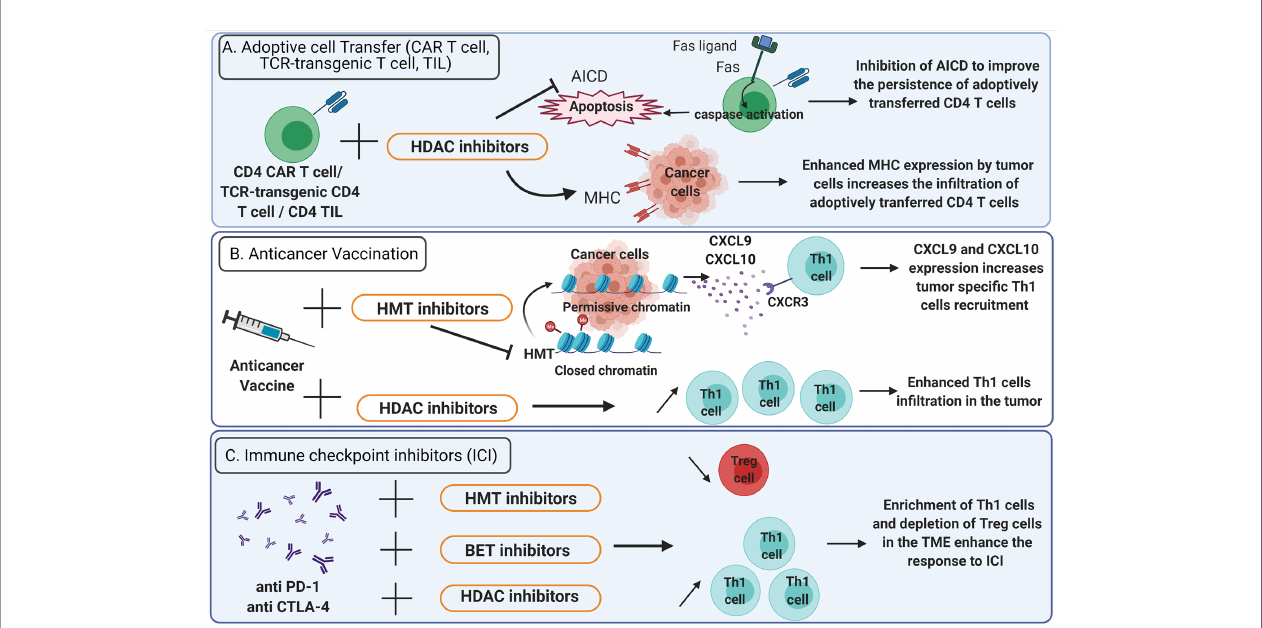
FIGURE 3 | Epigenetic therapies potentiate the ef fi cacy of anticancer immunotherapy. (A) Adoptive cell transfer. To improve the persistence of adoptively transferred CD4 + CAR T cells, TCR-transgenic CD4 + T cells or CD4 + TIL in the TME, activation induced cell death (AICD) can be inhibited using HDAC inhibitors (bar-headed line). AICD is mediated by Fas-Fas ligand interactions and triggers the activation of caspases that lead to apoptosis (solid arrows). HDAC inhibitors also enhance MHC expression on tumor cells thus increasing the in fi ltration of adoptively transferred CD4 + T cells. (B) Anticancer vaccination: HDAC inhibitors favor Th1 cells enrichment in the TME. HMT inhibitors promote the expression of CXCL9 and CXCL10 by tumor cells and enhance the recruitment of Th1 cells expressing CXCR3. (C) Immune checkpoint inhibitors: the ef fi cacy of anti-PD-1 and anti-CTLA-4 is enhanced by HDAC, HMT and BET inhibitors which favor a TME enriched in Th1 cells and depleted in Treg cells. TME, Tumor microenvironment; TIL, Tumor in fi ltrating lymphocytes; CAR T cells, chimeric antigen receptor T cells; HDAC, Histone deacetylase; HMT, histone methyltransferase; BET, bromodomain and extra-terminal domain family